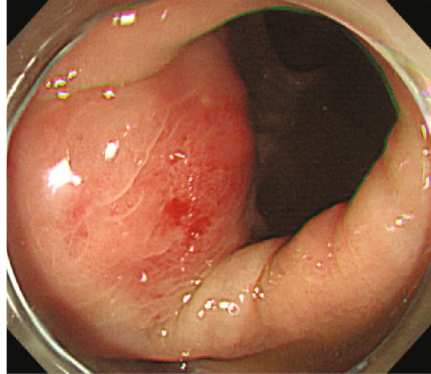
Figure 2: Colonoscopic fi nding. Nonulcerative, round, hyperemic lesion protrudes from the splenic fl exure of the large intestine.